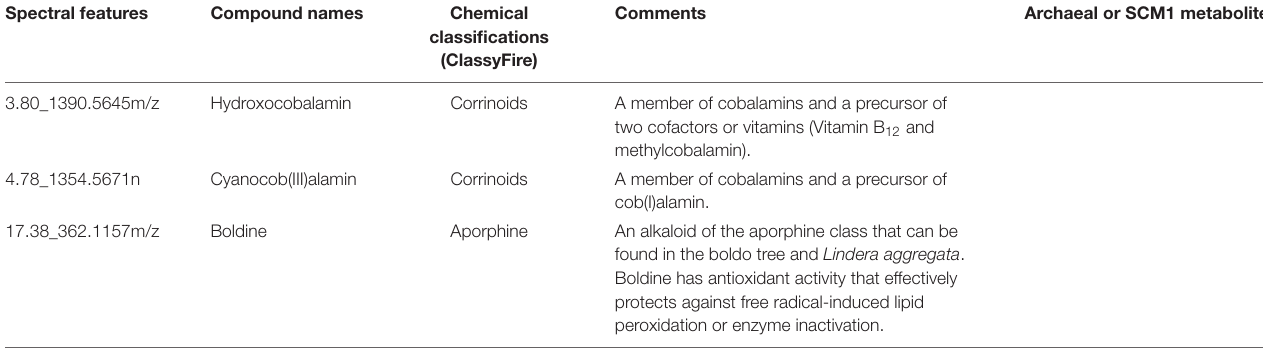
TABLE 2 | Chemical classifications of the annotated spectral features that are increased in the culture media with the supplement of Vitamin B 12 .